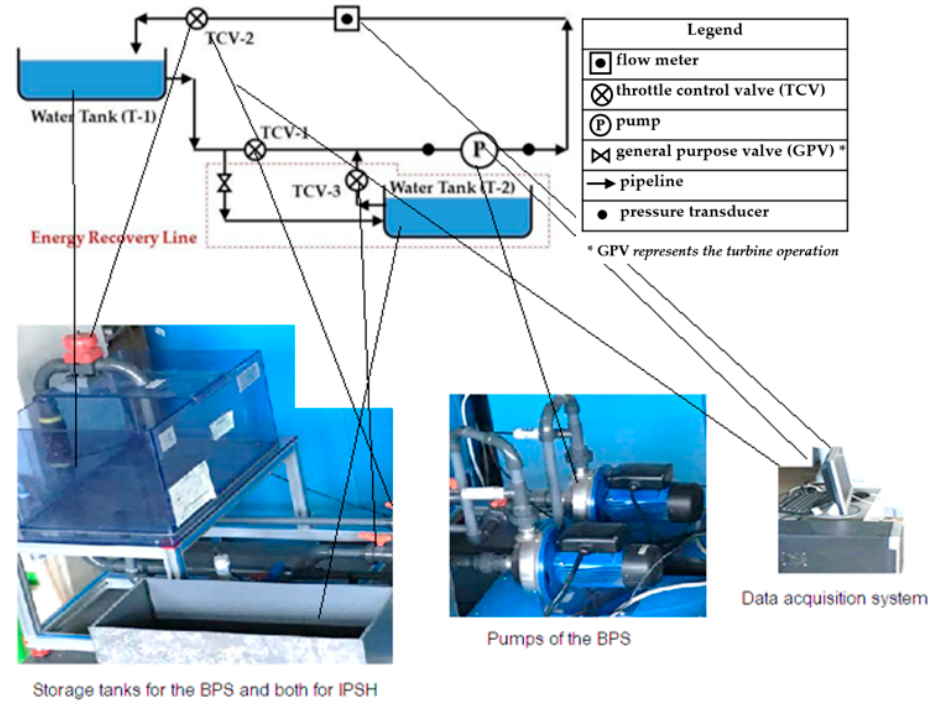
Figure 12. Scheme and visualization of the experimental set-up of the inline pumped-storage hydro (IPSH) solution.